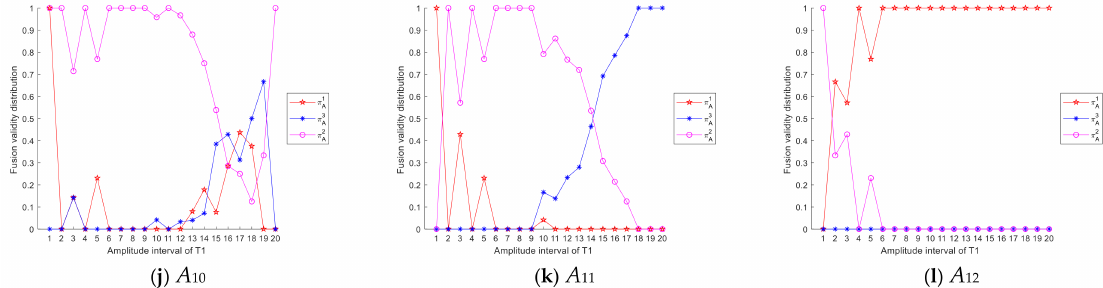
Figure 5. Fusion validity distribution of difference feature M to various algorithms.